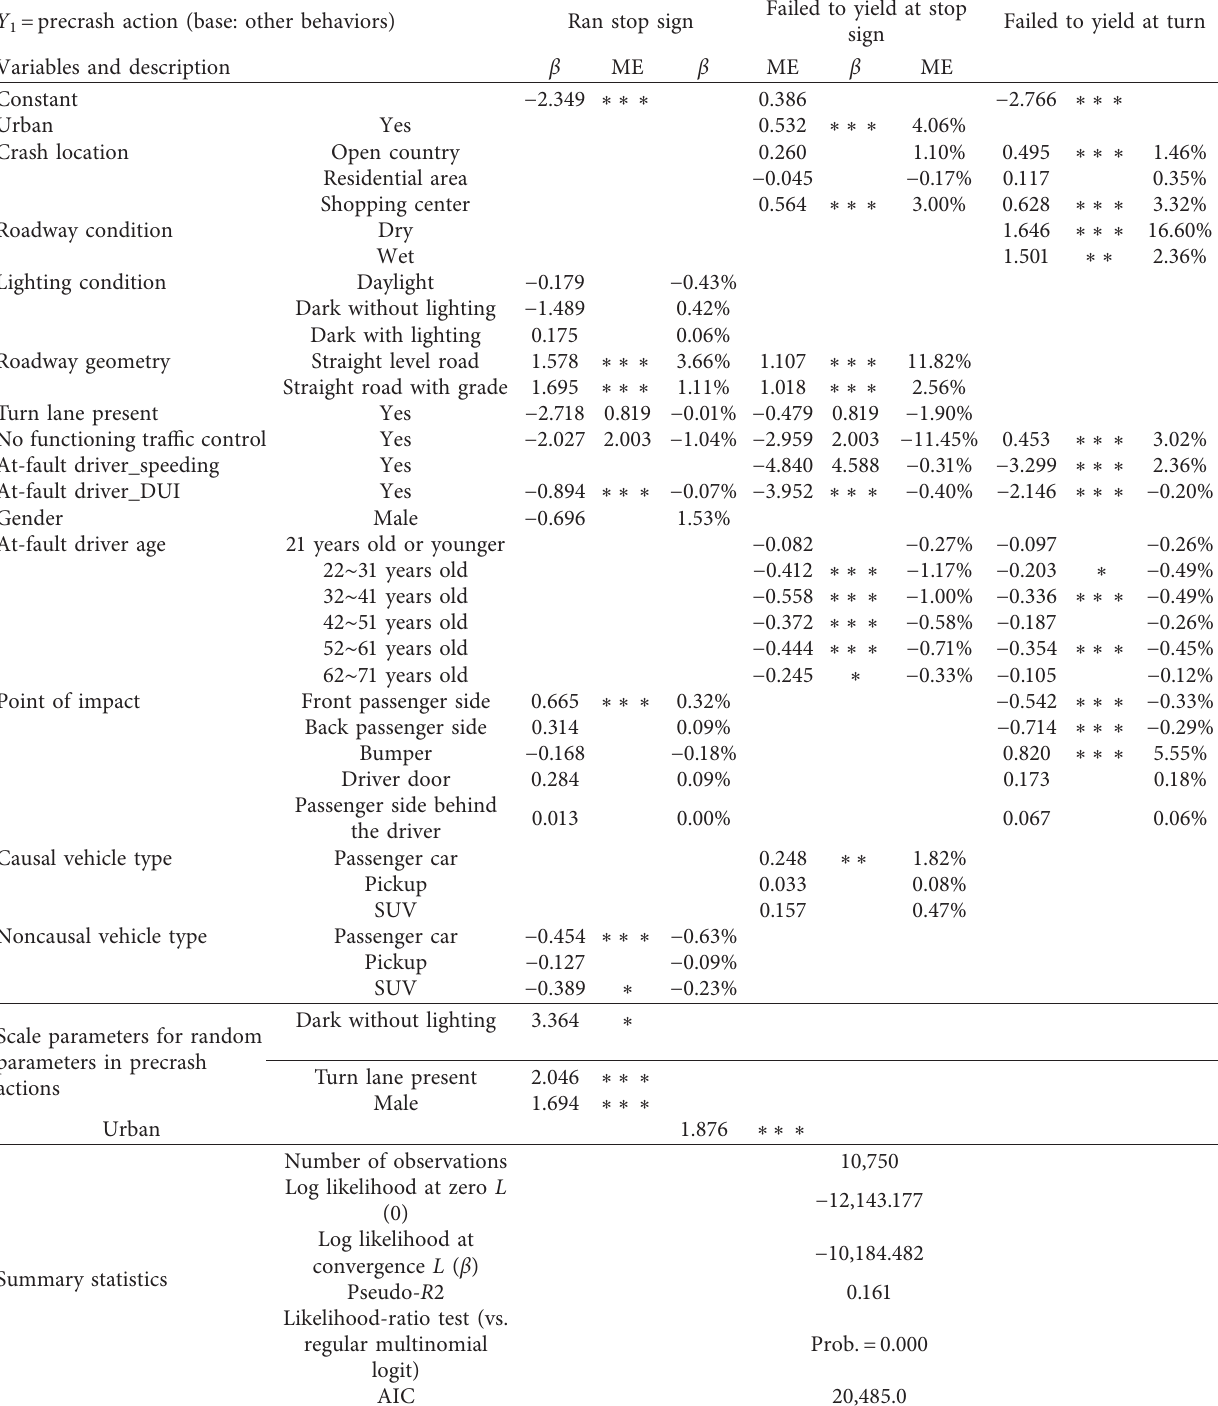
Table 6: Random-parameter multinomial logit model of precrash actions for side impact crashes at T-junctions. Y 1 � precrash action (base: other